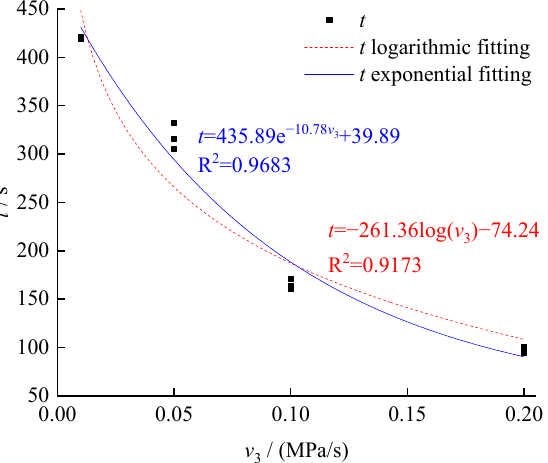
Figure 6. Relation between the time consumption of failure and unloading rate.